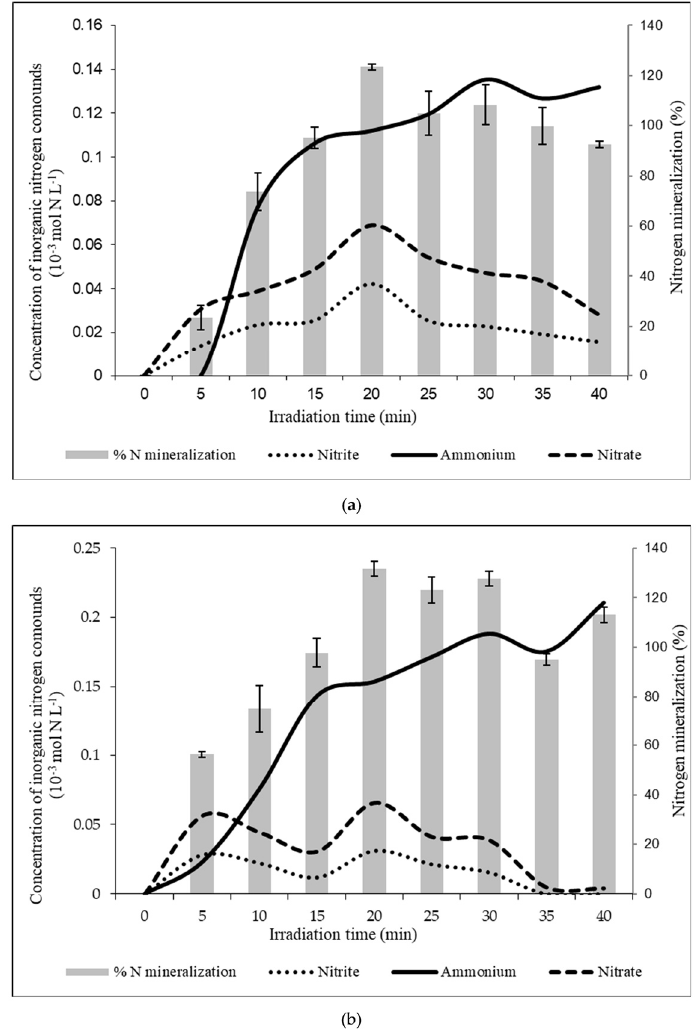
Figure 5. Evolution of inorganic forms of nitrogen ( left axis ) and nitrogen mineralization ( right axis ) during photocatalytic degradation of PNA carried out with: ( a ) Ti deposed on Si; ( b ) Ti foil.